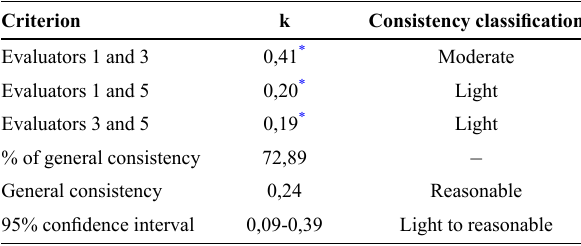
Table 4 - Inter-evaluator consistency for the items proposed on the crawl swimming technique observation